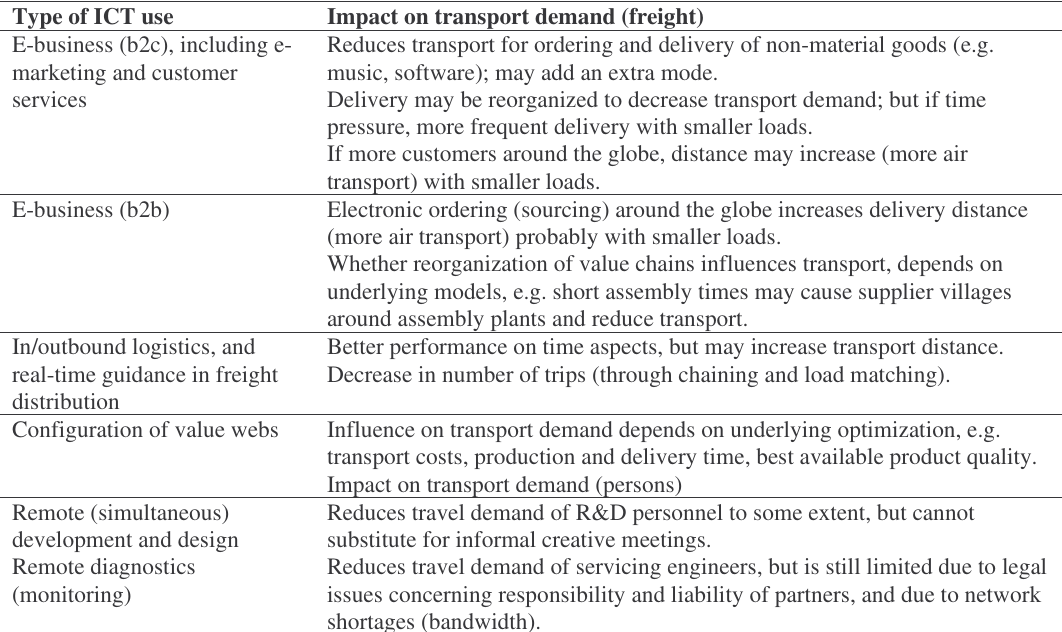
Table 3. ICT use by businesses and transport demand Type of ICT